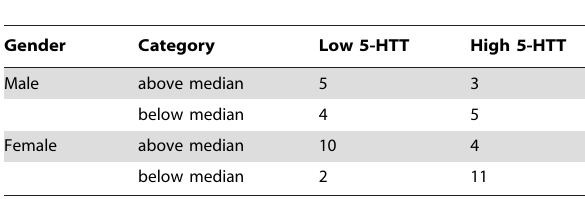
Table 2. Contingency table for heat-pain thresholds.